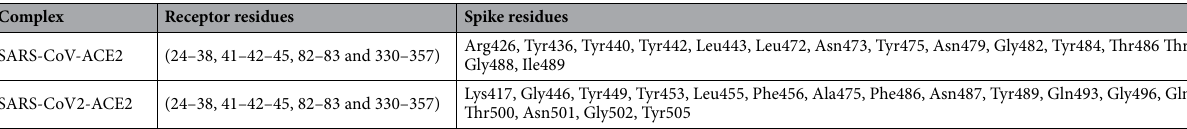
Table 1. The interaction list for SARS-CoV-ACE2 and SARS-CoV2-ACE2 complexes obtained from Ligplot +